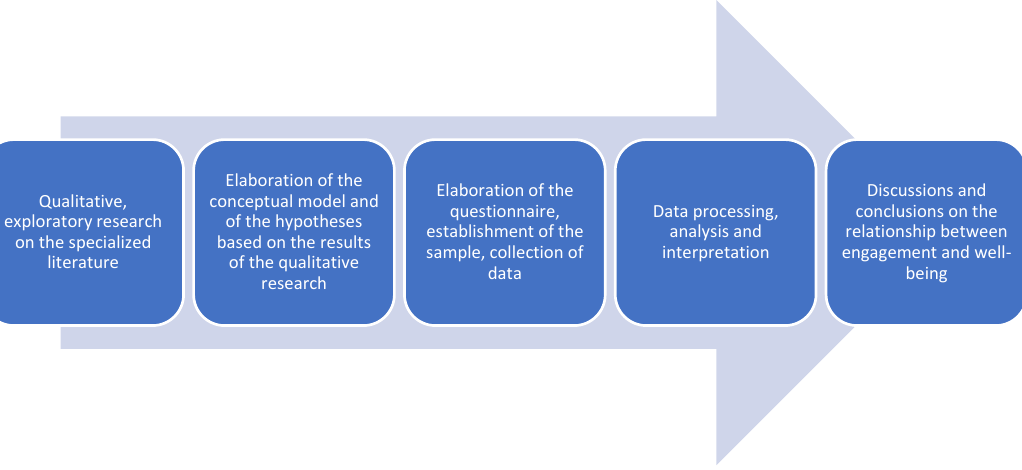
Figure 1. The research process. Source: Developed by the authors.